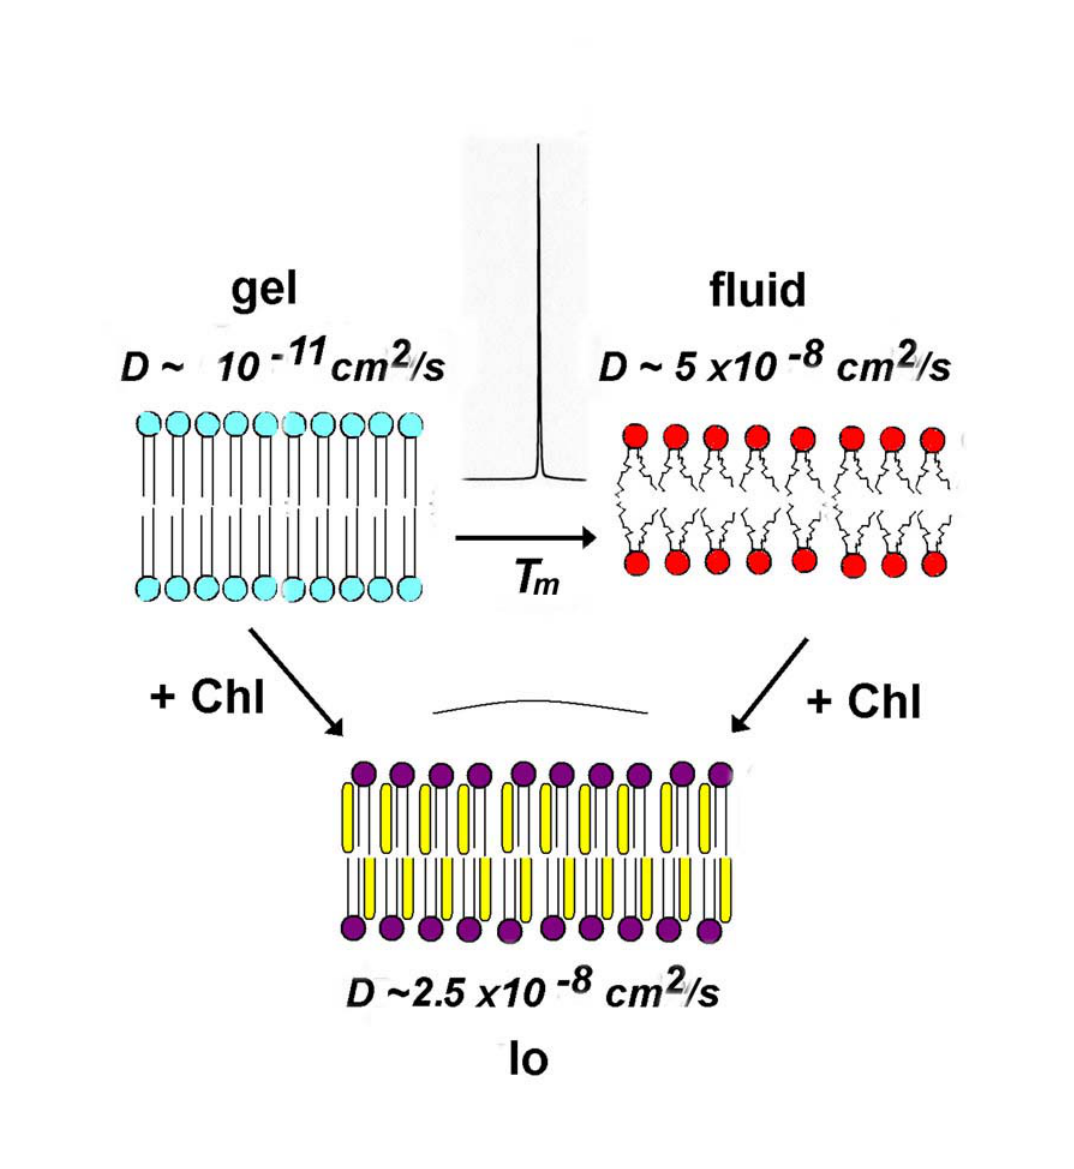
FIGURE 1 . Phase behavior of phospholipids. In the presence of aqueous buffer, a majority of membrane phospholipids form spontaneously solvated lipid bilayers that can exist in two distinct physical states, gel and fluid, according to the temperature. In the gel phase, molecules are tightly packed in a quasi-hexagonal array with their extended and ordered fatty acid chains lying parallel to each other. Intra- and intermolecular motions are slow, with lateral diffusion coefficient D < 10 –11 cm 2 /s. In the fluid phase, acyl chains are highly mobile and the molecules undergo fast rotational and lateral (D) diffusion. This is accompanied by a thinning of the bilayer. For pure phospholipid species, the fluid to gel transition is characterized by a melting temperature, Tm, recorded as a sharp peak by differential scanning calorimetry. Upon addition of cholesterol (20–25 mol% for mono- and disaturated phosphatidylcholines), the sharp peak is abolished and the lipid bilayer is in a liquid ordered (l o ) phase. In the l o phase, the acyl chains are ordered and relatively extended but the molecules have a high rotational and lateral